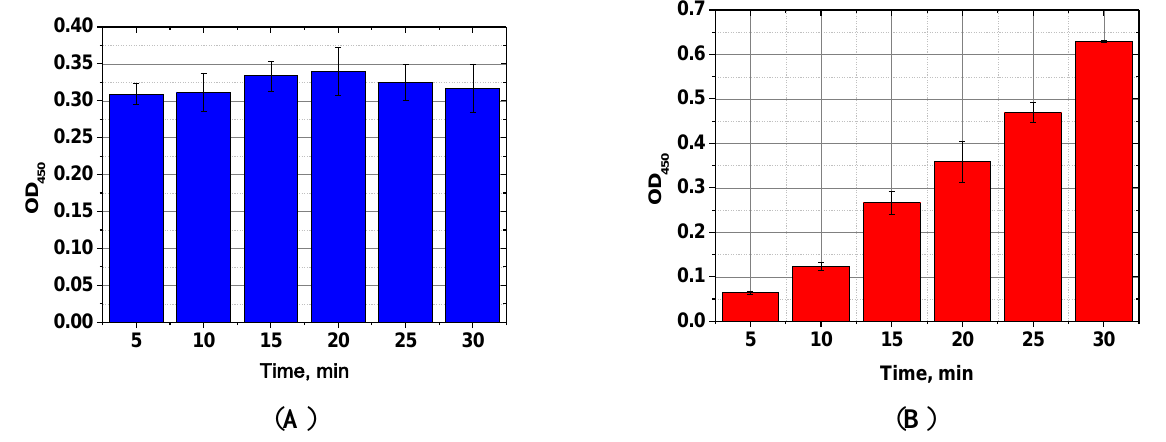
Figure 3. Effect of incubation period on the signal intensity of MNP-based ELISA for AFB1 detection. The AFB1 concentration was 60 pg/mL. No significant effect was observed and 5-min incubation was sufficient for near complete interaction ( A ). Effect of AFB1 and MNP-antibody incubation period on the signal intensity of microplate ELISA for AFB1 detection. No signal plateau was observed over the tested range ( B ). The measurements were performed in